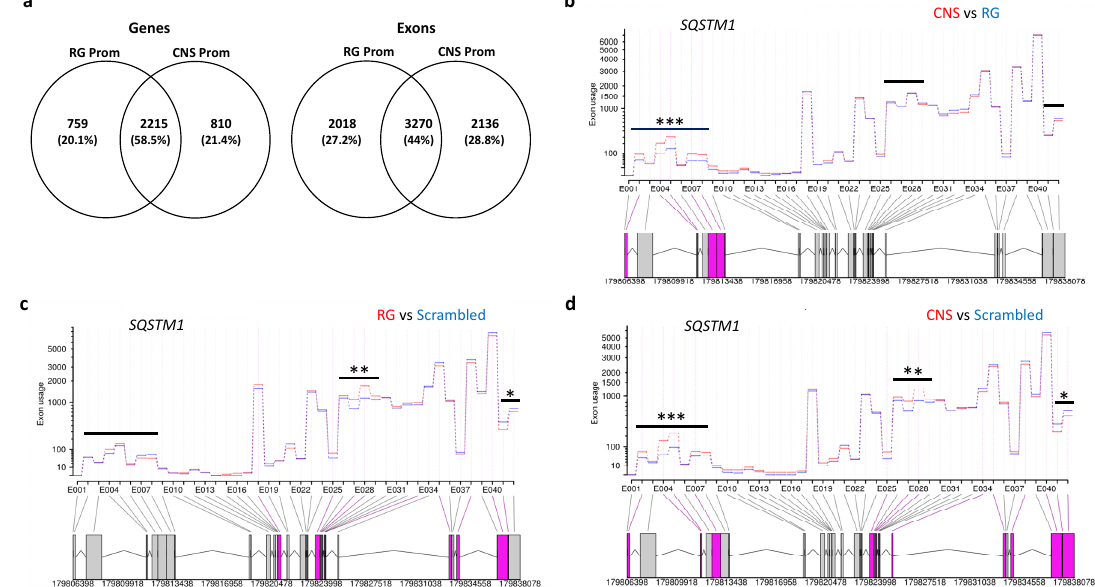
Figure 7. CNS-specific and reference PGC-1 α proteins affect exon usage via distinct and similar mechanisms. ( a ) Venn diagram showing the number of genes (left) or exons (right) alternatively spliced after activation of the RG or the CNS promoters in comparison to cells transfected with scrambled sgRNAs. Exon usage of SQSTM1 after RG and CNS promoter activation reveals similar changes to transfections of scrambled sgRNAs (control) and additional differences between each other; comparison between ( b ) CNS and RG promoter activation, ( c ) RG promoter activation and control and ( d ) CNS promoter activation and control; different exon usage between pairwise comparisons is indicated by purple boxes representing the affected exon bins; significant differences ( p < 0.0001) are highlighted by stars; * and **, regions different between RG or CNS vs. scrambled; ***, region, different between CNS vs. RG or scrambled. The black lines refer to differences in any